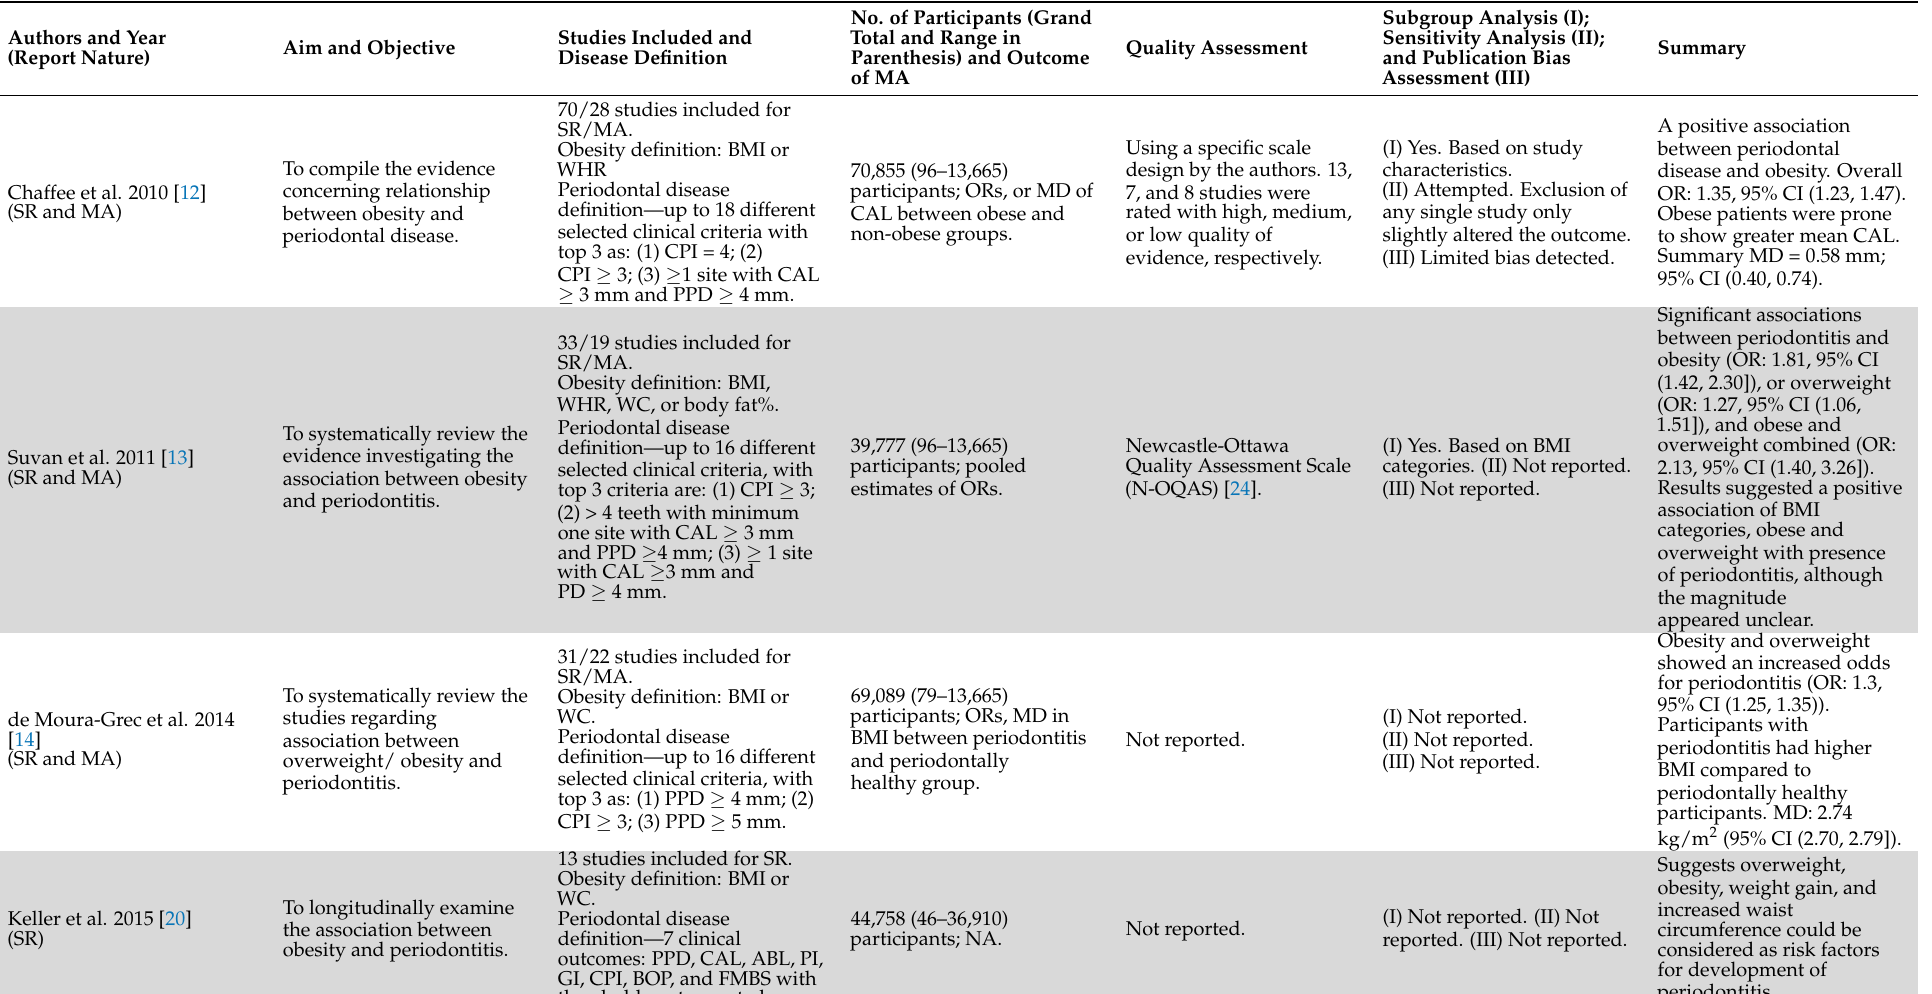
Table 1. Systematic reviews and meta-analyses evaluating the association between obesity and periodontal disease (in chronological